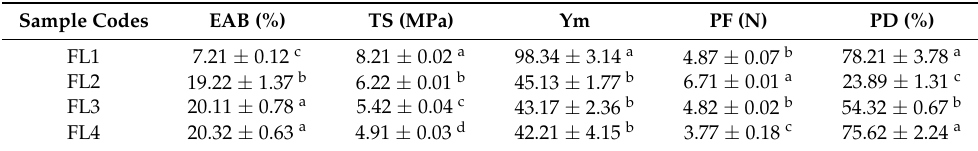
Figure 1. Visual assessment of films: control or FL1 (CA+SA); FL2: CA + SA + OEO (1.5% v / v ); FL3: CA + SA + OEO (2% v / v ); FL4: CA + SA + OEO (2.5% v / v ). Table 2. Mechanical properties of CA–SA and CA–SA–OEO